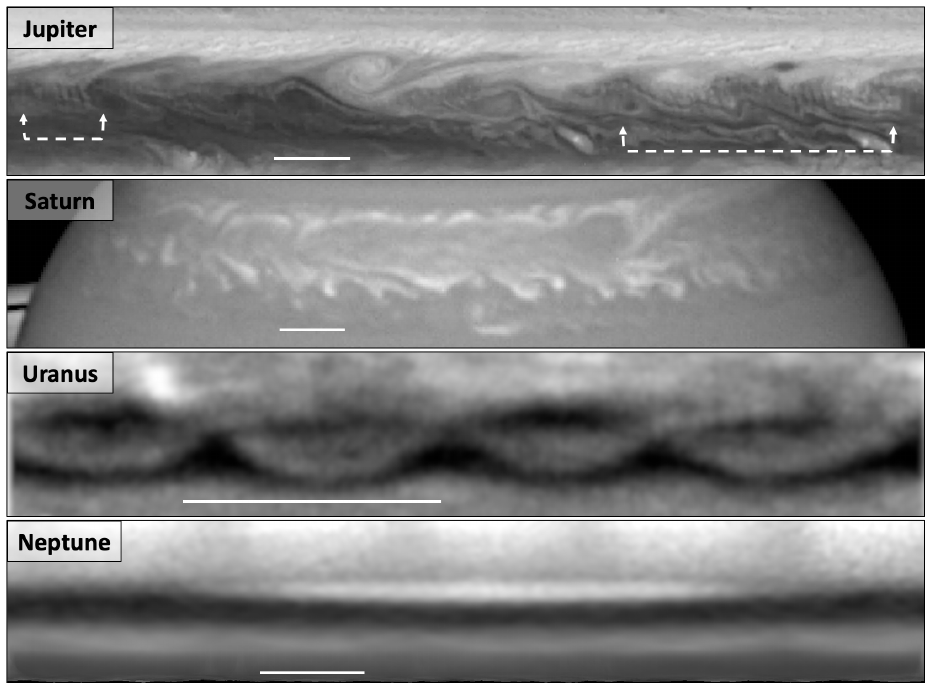
Figure 13. Planetary waves at multiple scales; solid line indicates 10,000 km. Jupiter in 2015 at 395 nm shows fine-scale waves (dashed arrows) superimposed on a cyclone/anticyclone vortex street at 16 ◦ N latitude [140]. Saturn in 2011 at 502 nm shows a wavy structure along the edges of the expanding storm plume at 40 ◦ N latitude. Uranus in 2012 at 1.6 microns, showing braided equatorial waves [24]. Neptune in 2021 at 467 nm shows a wave number 1 feature centered at 55 ◦ S